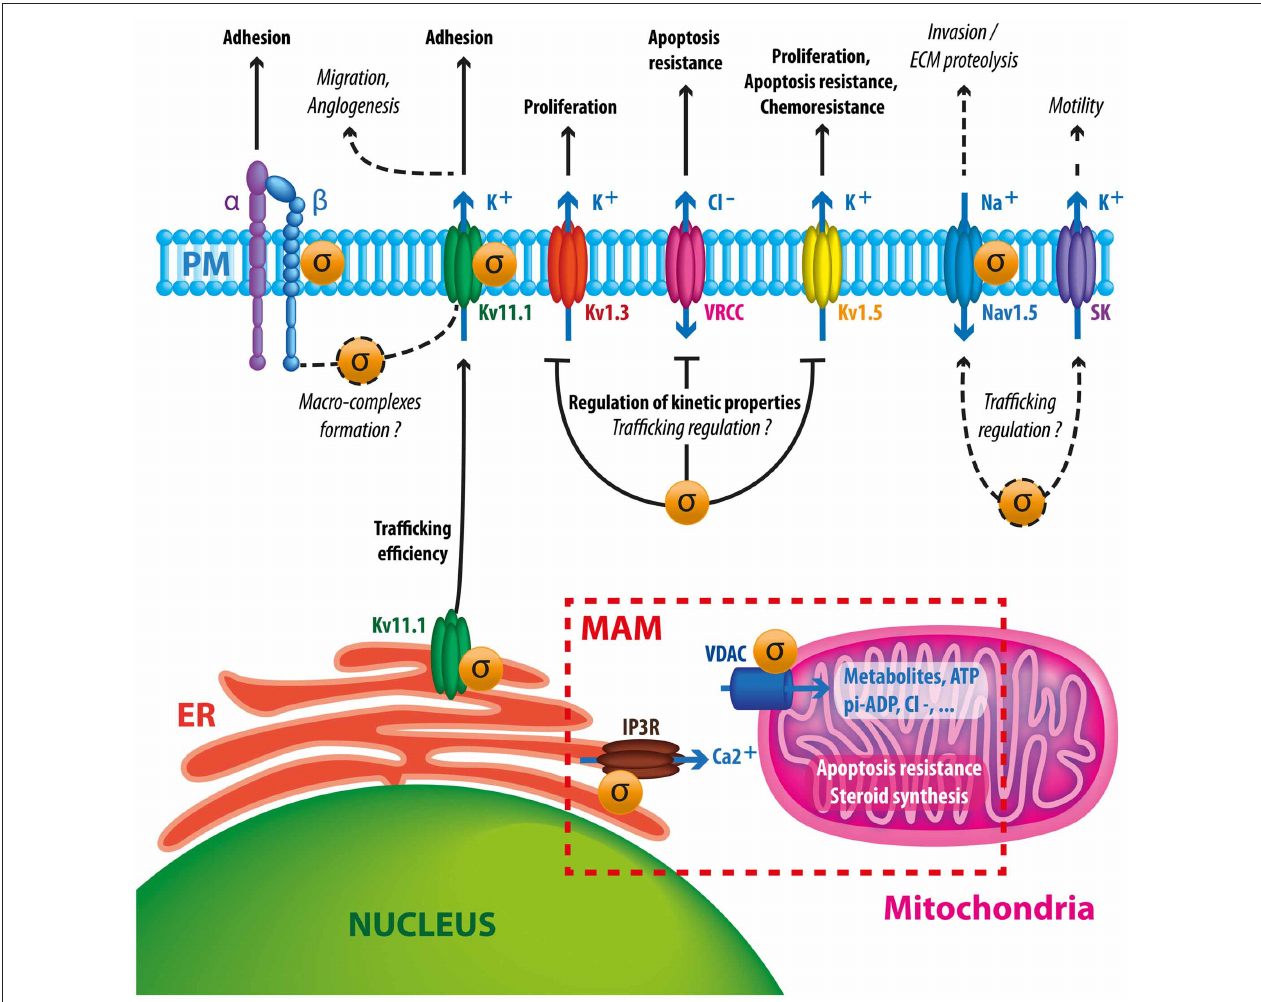
FIGURE 2 | Schematic diagram summarizing putative and documented interactions between Sig1R and ion channels in cancer cells. Sig1R promotes hERG maturation and membrane stability which may potentiate channel interaction with β 1 integrin macrocomplexes, leading to enhanced migration and angiogenesis. Sig1R also directly binds to other VGIC such as Kv1.3, Kv1.5, and Nav1.5 controlling either current density or kinetic properties of channels. These interactions may have consequenceson cell